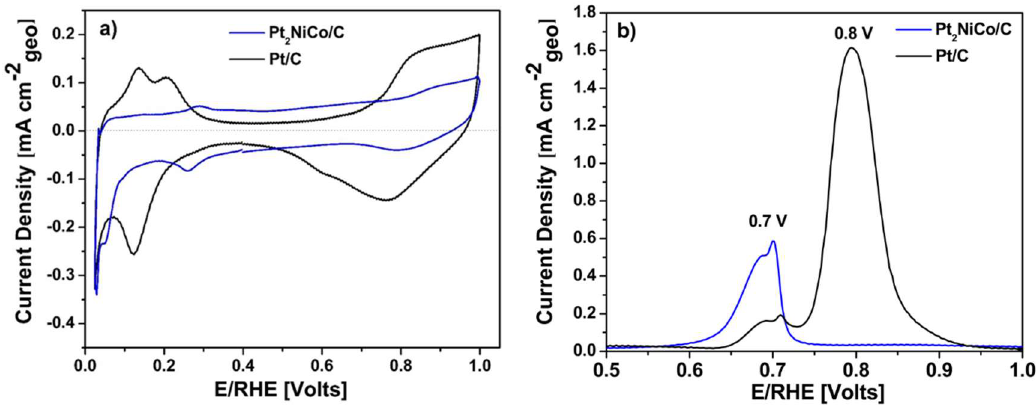
Figure 5. ( a ) Cyclic voltammograms of the Pt 2 NiCo / C and Pt / C nanocatalysts measured at 20 mV s − 1 . ( b ) CO electrooxidation peaks of Pt 2 NiCo / C and Pt / C nanocatalysts with a scan rate of 20 mV s − 1 .